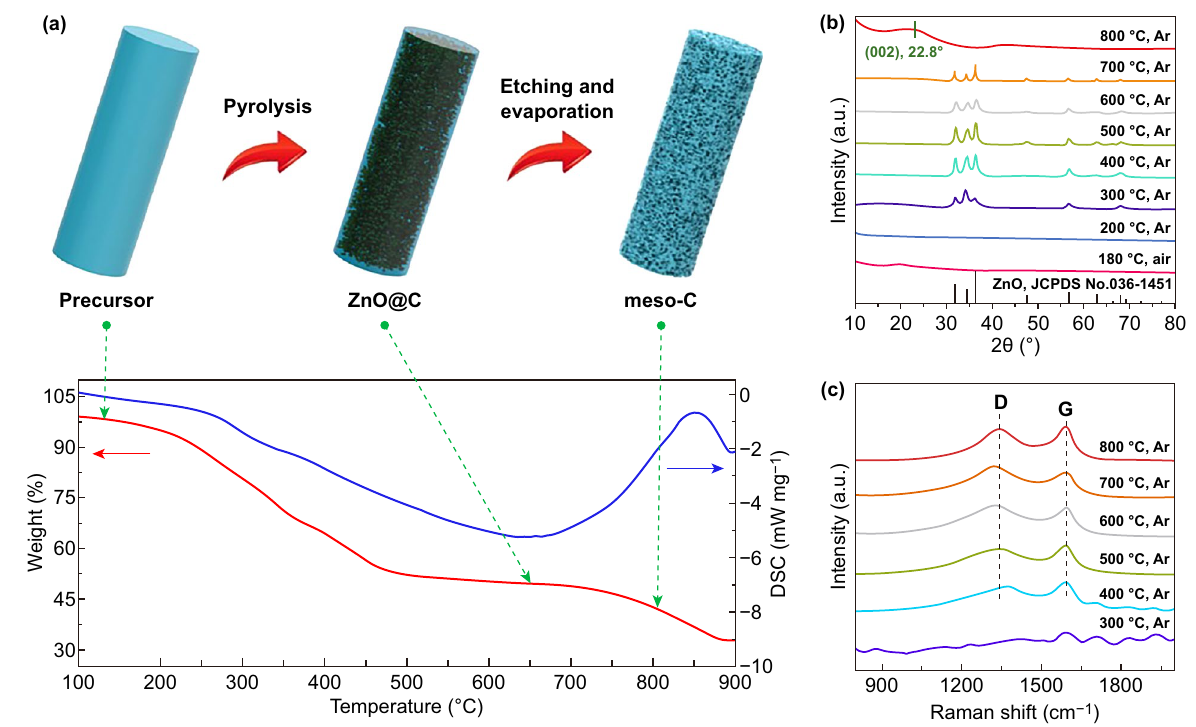
Fig. 1 Formation mechanism of meso-C. a Schematic diagram for the formation of meso-C and the TG/DSC curves of Zn(Ac) 2 /PVA during heat treatment in Ar atmosphere. b , c Temperature-dependent ex situ XRD and ex situ Raman spectra during the formation processes of meso-C,